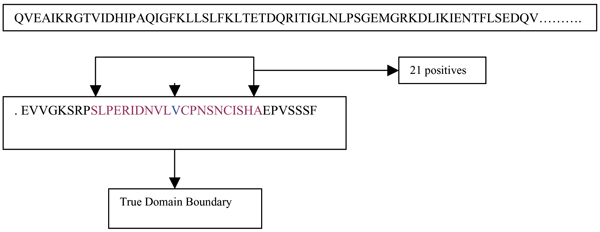
Example of Input Array for a Window Size of 21. True boundary here is the residue that SCOP defines as a boundary residue. In case of positive example, we select 10 residues from each side of the true boundary residue and for negative example; we randomly select 21 residues from the rest of the protein chain.